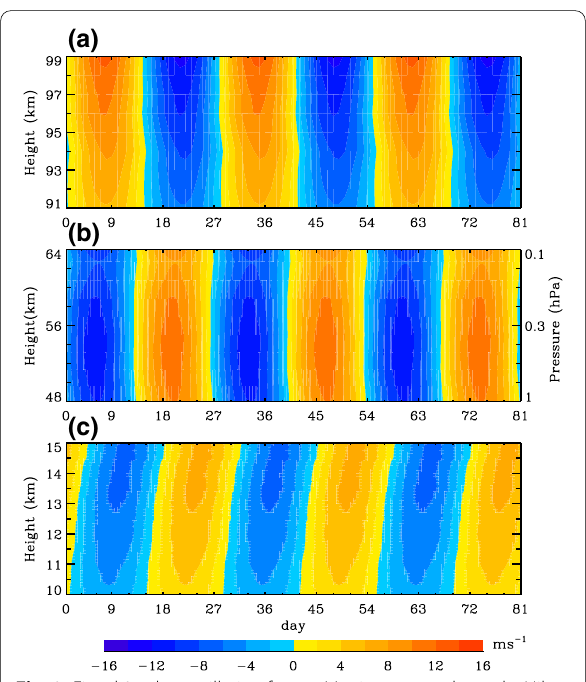
Fig. 10 Wavelet spectrum of OLR at (20° N, 157.5° W) and (15° S, 170° W), close to Maui and Pago Pago,